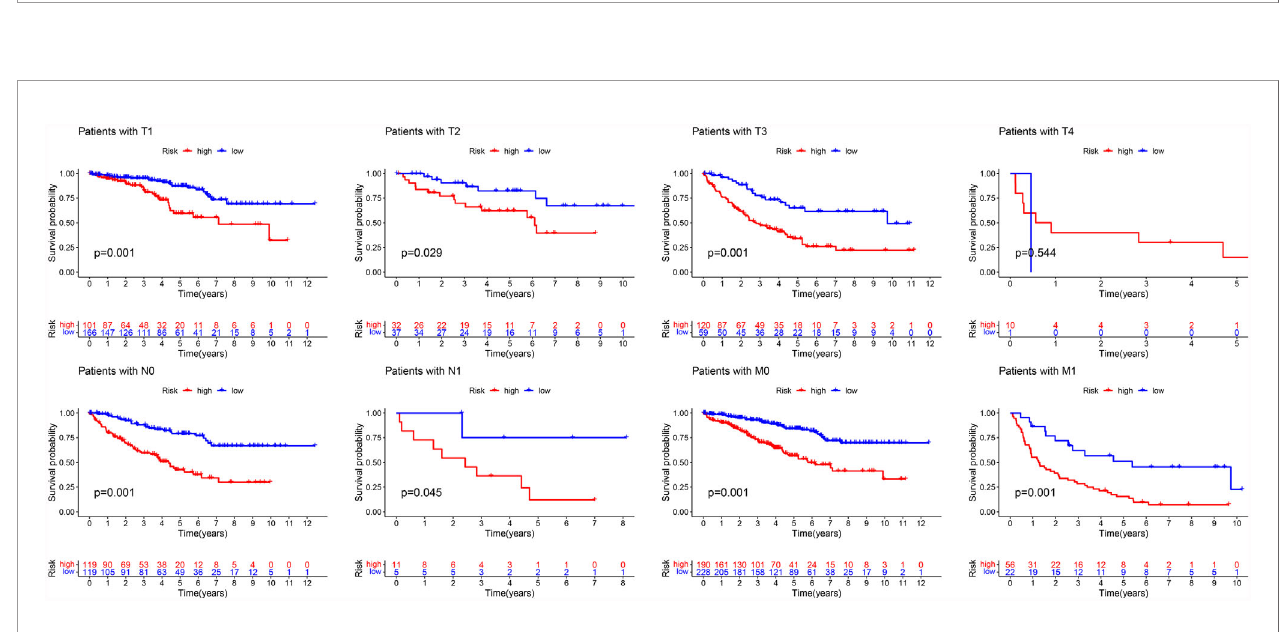
FIGURE 12 | Strati fi ed survival analysis of patients with different TMN